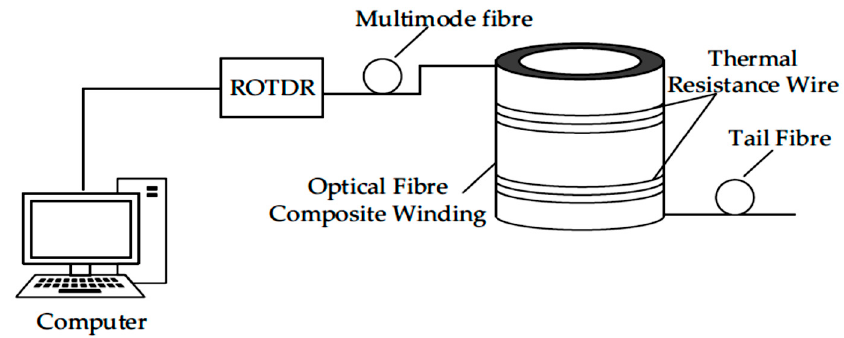
Figure 7. Temperature measurement system using optical fiber [63].